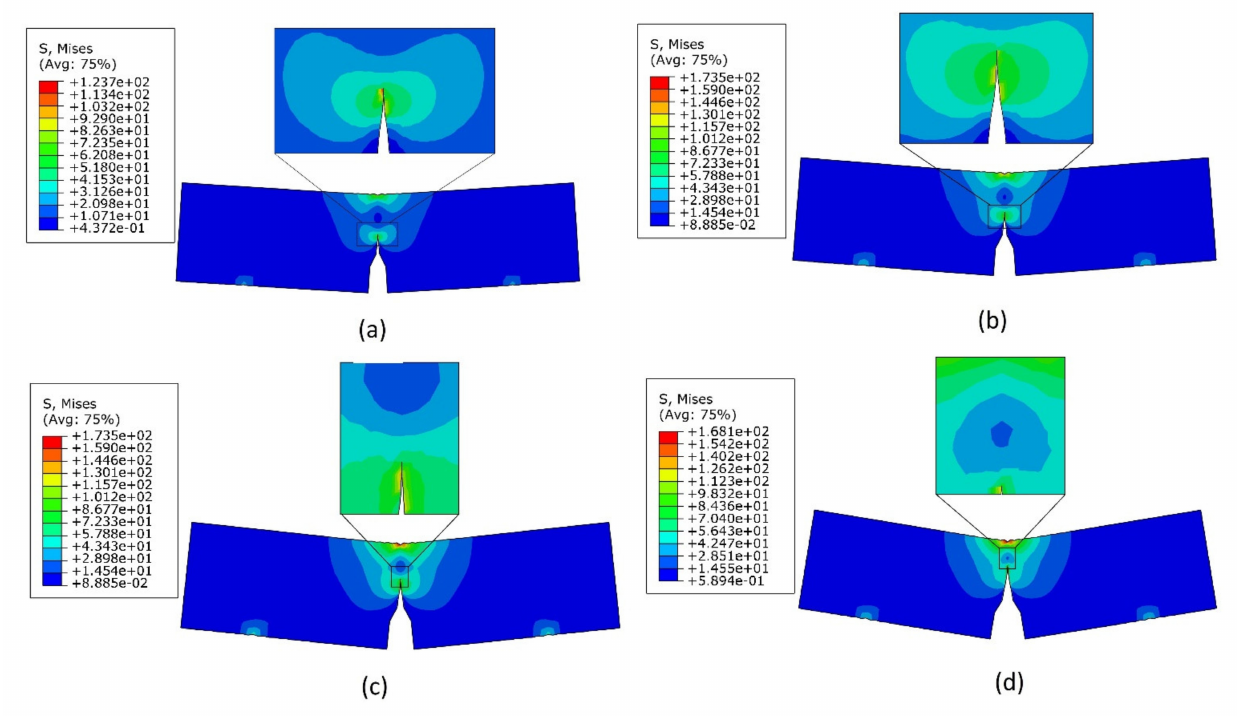
Figure 9. Von Mises stress distribution at ( a ) loading ( b ) crack initiation ( c ), ( d ) crack